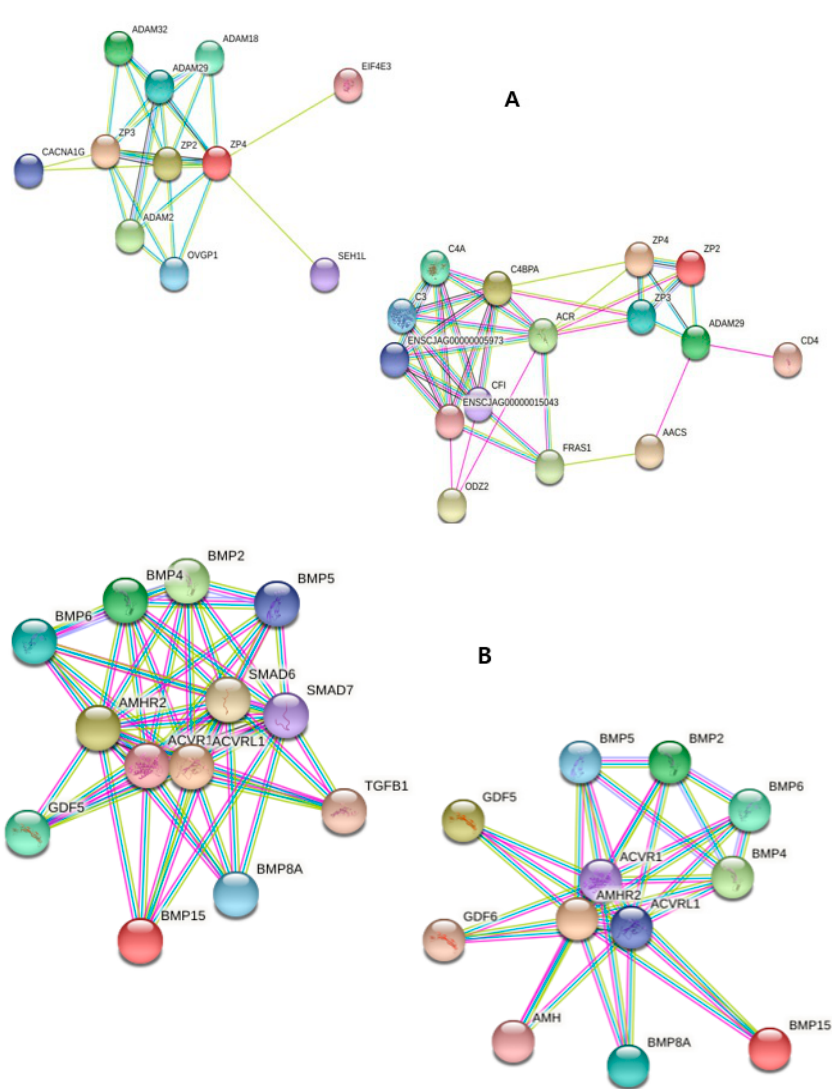
Figure 7. Predictive interaction of specific proteins in marmoset oocytes. The interaction of the up-regulated genes with other genes at protein level was analyzed mainly using the STRING database. Comparison within monkey species was conducted; however, the annotation is not demonstrated due to the limitation of marmoset resources.